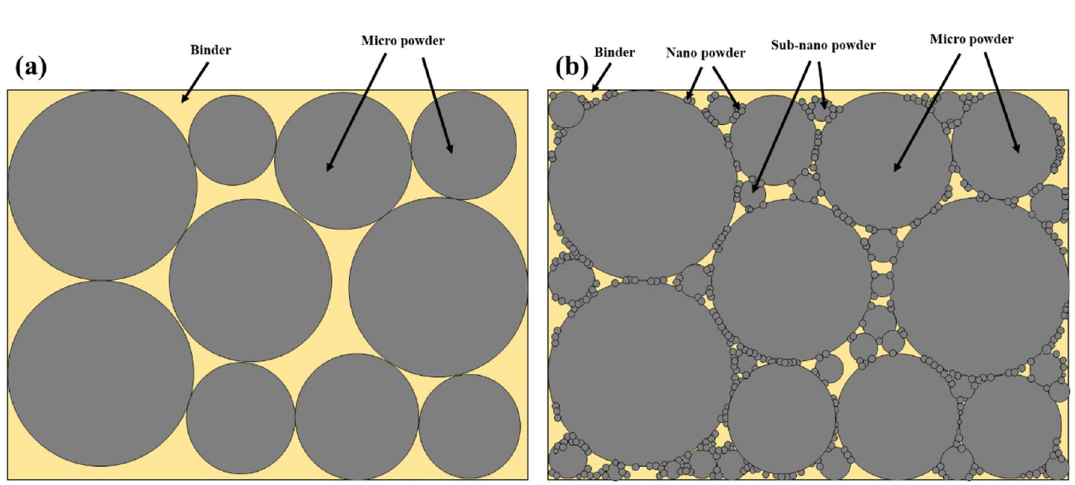
Figure 5. Schematic comparing its microstructure of ( a ) monomodal feedstock and ( b ) trimodal